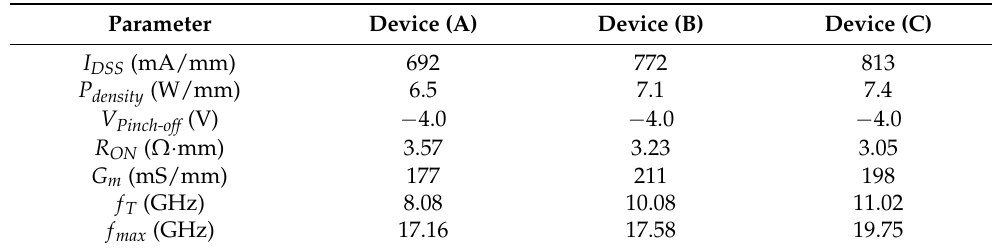
Table 1. DC (direct current) and RF (radio frequency) parameters for the fabricated three devices with 1 µ m gate length and 2-finger of 125 µ m width achieved at V ds = 4.5 V and V gs = − 2.5